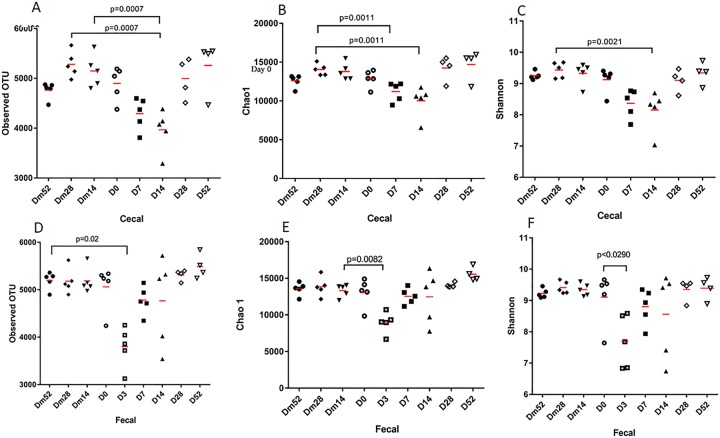
Alpha diversity measures by study day.(A) Observed OTUs of cecal samples. (B) Chao1 of cecal samples. (C) Shannon of cecal samples. (D) Observed OTUs of fecal samples. (E) Chao1 of fecal samples. (F) Shannon of fecal samples.